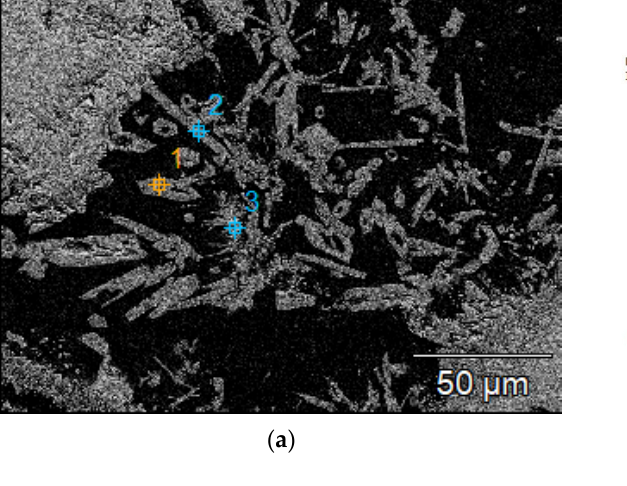
Figure 9. Elemental analysis of the middle zone of the surface layer of sample 4-PE ( a ) area under observation ( b ) X-radiation energy diagram of area under observation ( c – j ) elemental maps showing the position and amounts of elements present in the area under observation.